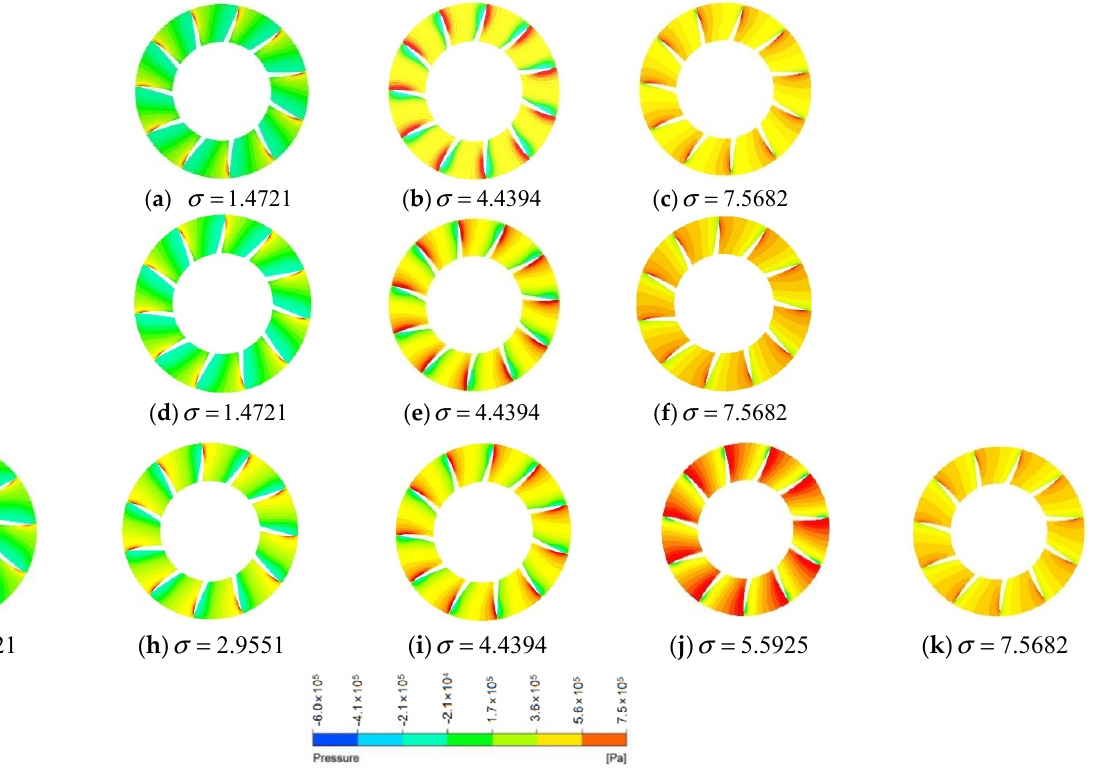
Figure 18. Pressure cloud of the rotor domain under different oblique angles and cavitation numbers. (Top: β = 0 ◦ , Center: β = 10 ◦ , Below: β = 20 ◦